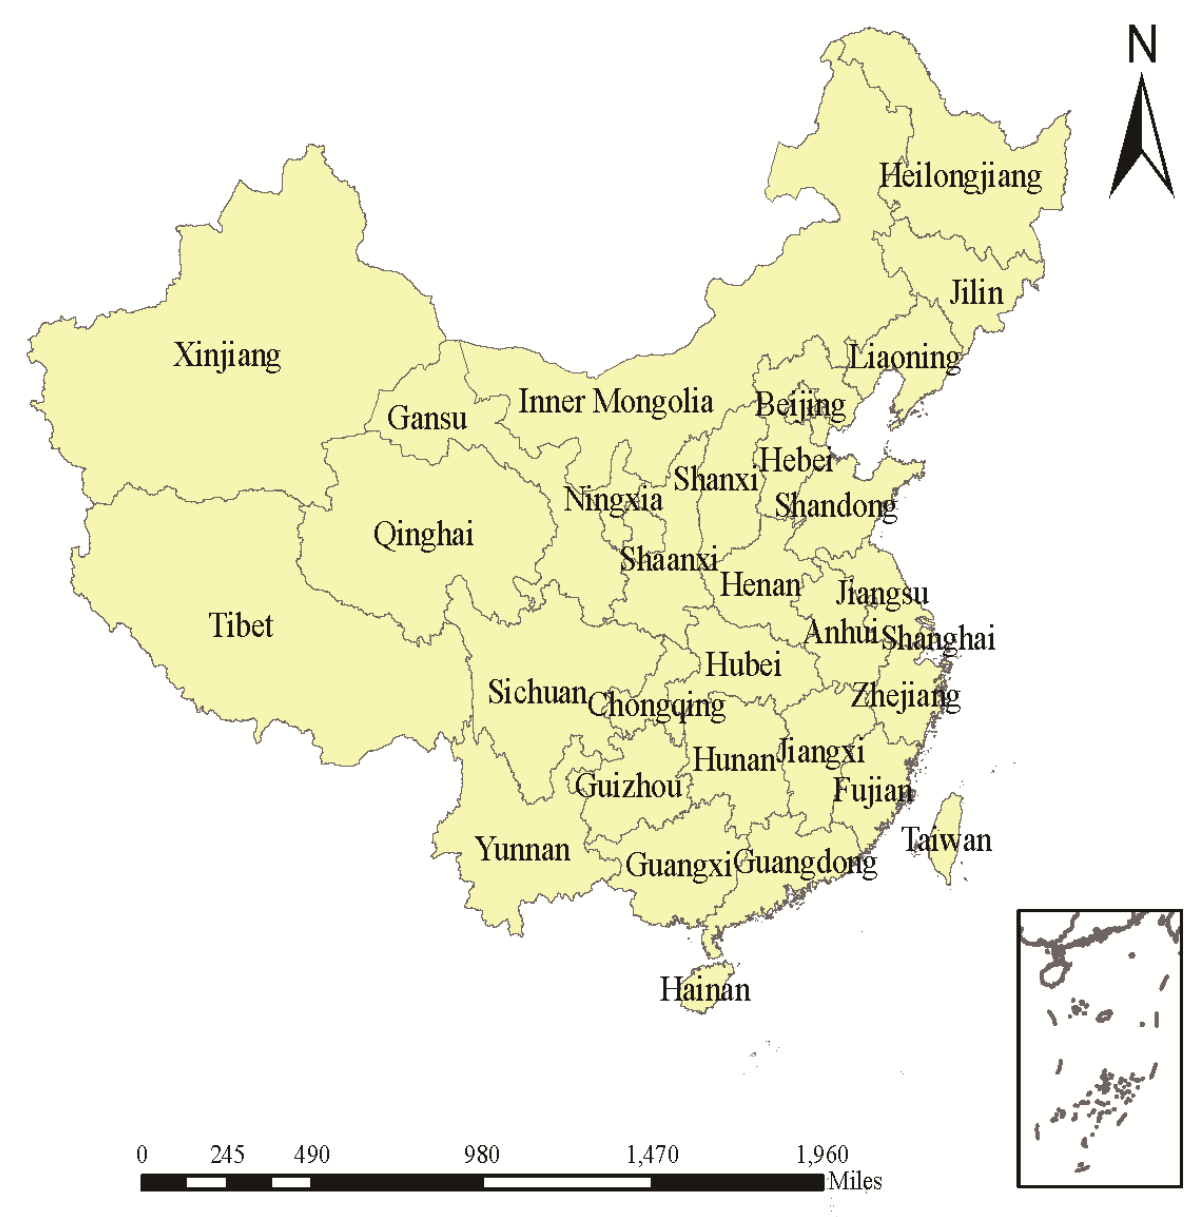
Figure 3. Map of China labeled with provinces names.